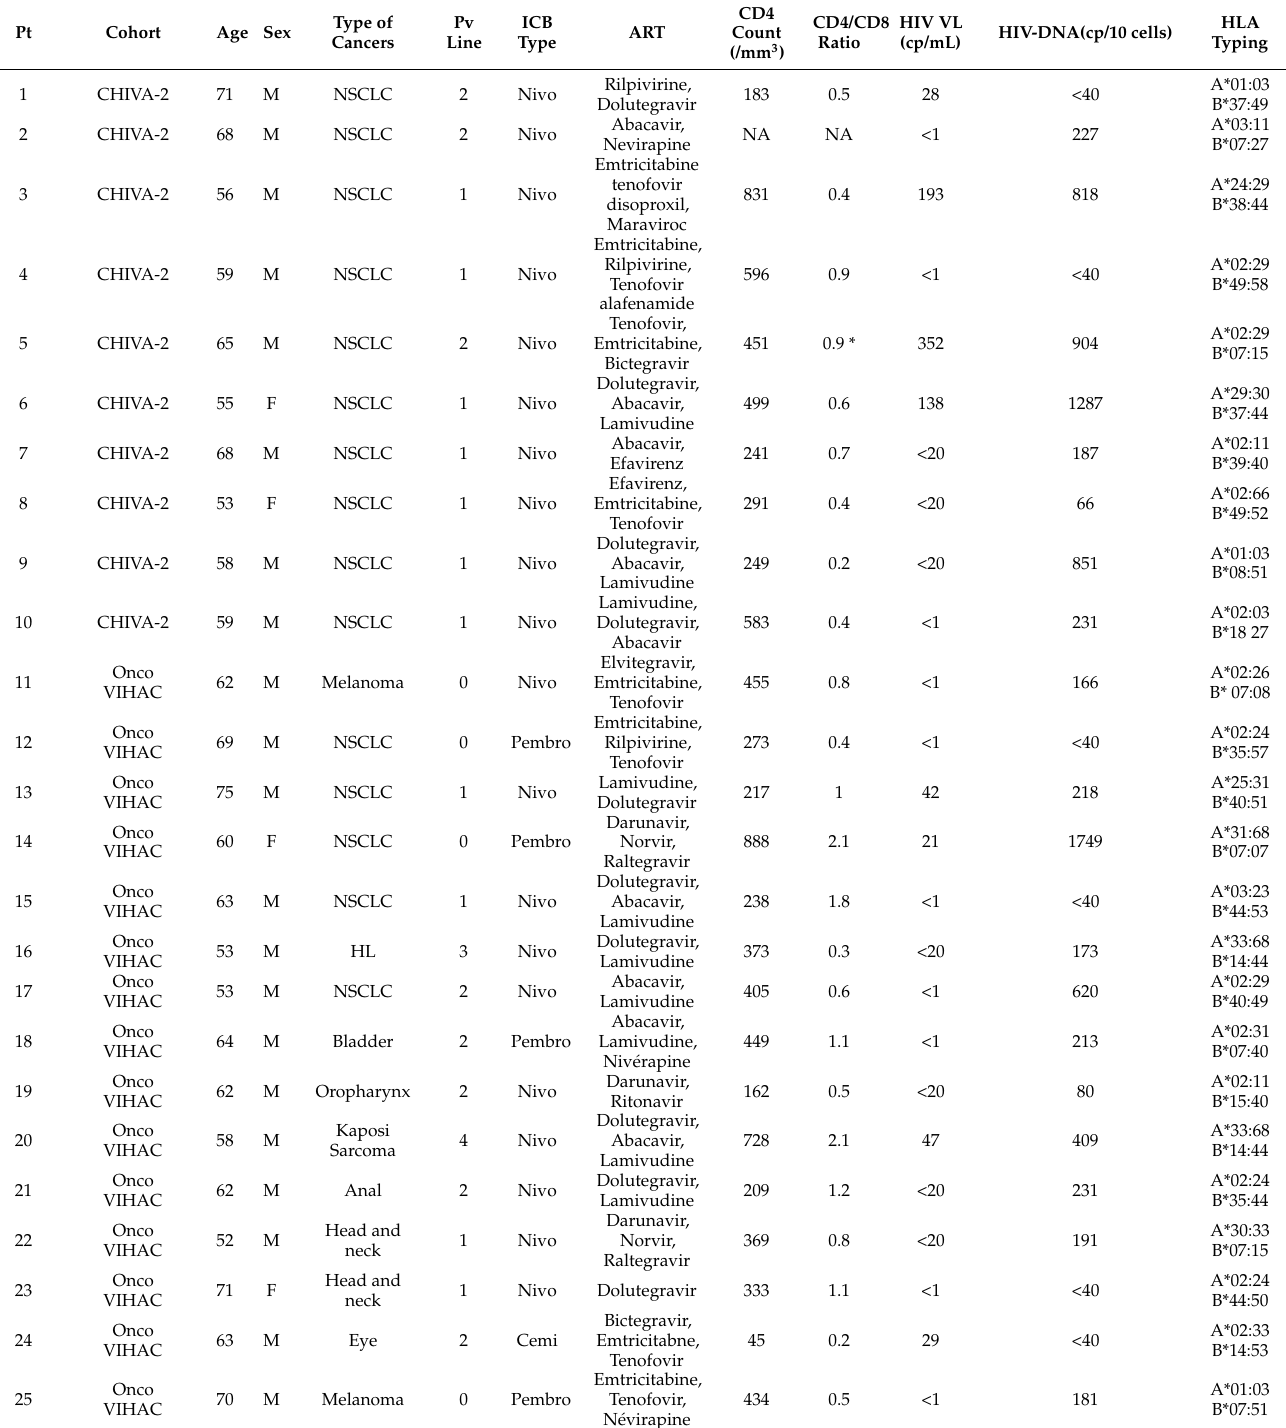
Table 1. Clinical and biological characteristics at